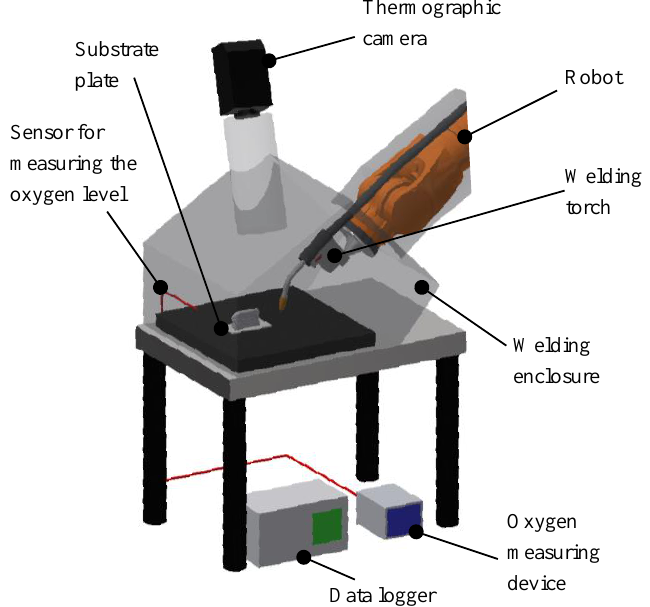
Figure 4. Experimental setup (reproduced from [14], under CC BY 4.0).